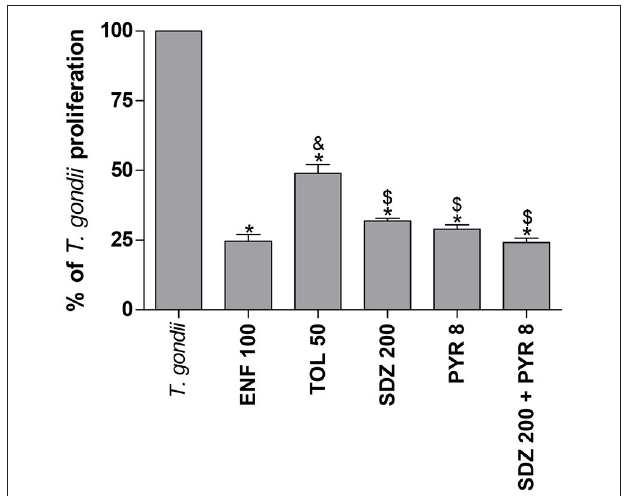
FIGURE 2 | Percentage (%) of T. gondii proliferation (2F1 clone) in BeWo cells treated with different drugs. BeWo cells were cultured in 96-well plates (3 × 10 4 cells/well/200 µ L) for 24h, infected with T. gondii (RH-2F1 clone) for 3 h, washed with medium to remove extracellular parasites and treated or not at the same time with different drugs ( µ g/mL): enrofloxacin (ENF), toltrazuril (TOL), sulfadiazine (SDZ), pyrimethamine (PYR), or combination of sulfadiazine and pyrimethamine (SDZ + PYR) for an additional 24h. Next, the cells were submitted to T. gondii intracellular proliferation assay ( β -galactosidase assay). Data were presented as mean ± SEM of the percentage (%) of T. gondii proliferation from three independent experiments in nine replicates. Significant differences in relation to infected and untreated cells ( T. gondii ) ( ∗ P < 0.05), ENF ( & P < 0.05), and TOL ( $ P < 0.05). Differences between groups were analyzed by One-Way ANOVA with the Bonferroni multiple comparison post-hoc